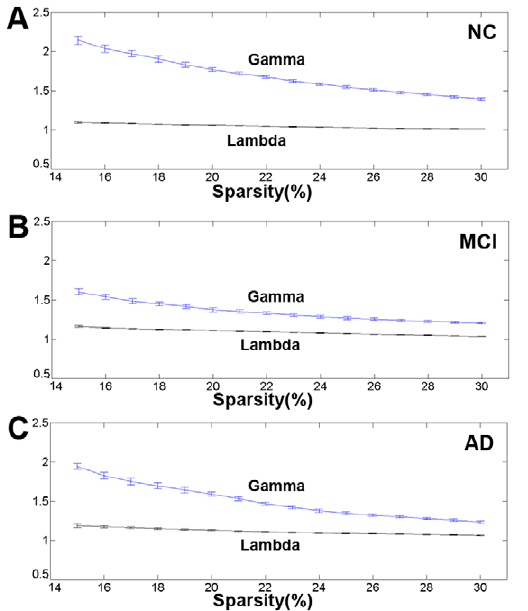
Figure 2. Small-world properties of the structural cortical networks. The graphs show the absolute path lengths (Gamma c =C preal /C prand ) and clustering coefficients (Lambda l =L preal /L prand ) over a wide range of sparsity values ( 15% ƒ S ƒ 30% ) and the error bars were obtained using bootstrap method. All the networks have c . 1 (the blue lines) and l < 1 (the black lines), which imply small-world properties. As the values of the sparsity thresholds increase, the c values decrease rapidly and the l values change only slightly. A – The values of Gamma and Lambda in NC. B – The values of Gamma and Lambda in MCI. C – The values of Gamma and Lambda in AD.